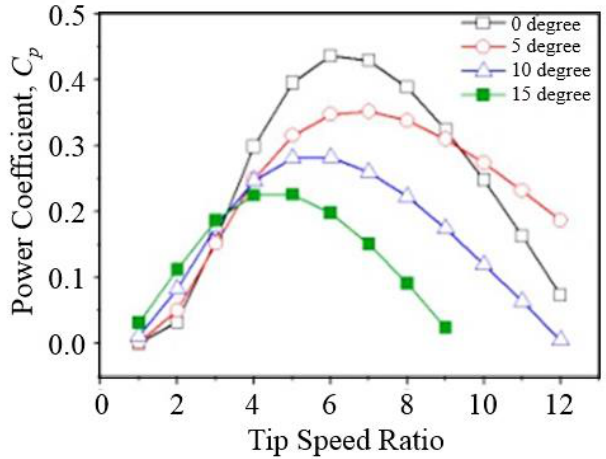
ffi cient variation for di ff erent blade Figure 1. Wind power coefficient variation for different blade angles. Figure 1. Wind power coe